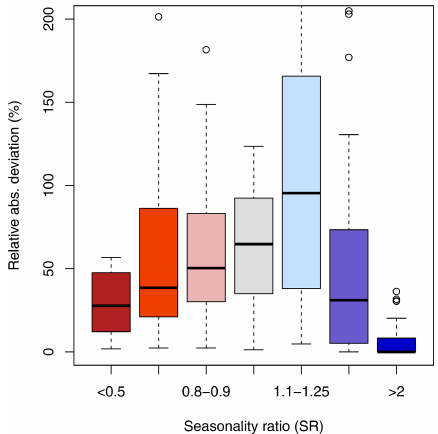
Figure 7. Performance gain by seasonality ratio classes of Laaha and Blöschl (2006b). Shown are the relative absolute devia- tions (rad T ) for the T = 100-year event. The colour coding is that of Fig.